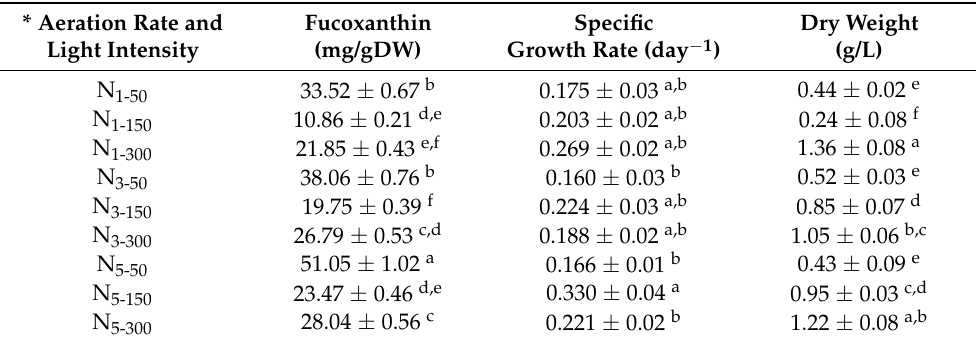
* Aeration rates (1-3-5 L/min) and Light intensities (50-150-300 µmol/m 2 s), abcdef Values for each stage within the same column bearing different superscripts are significantly different ( p < 0.05).